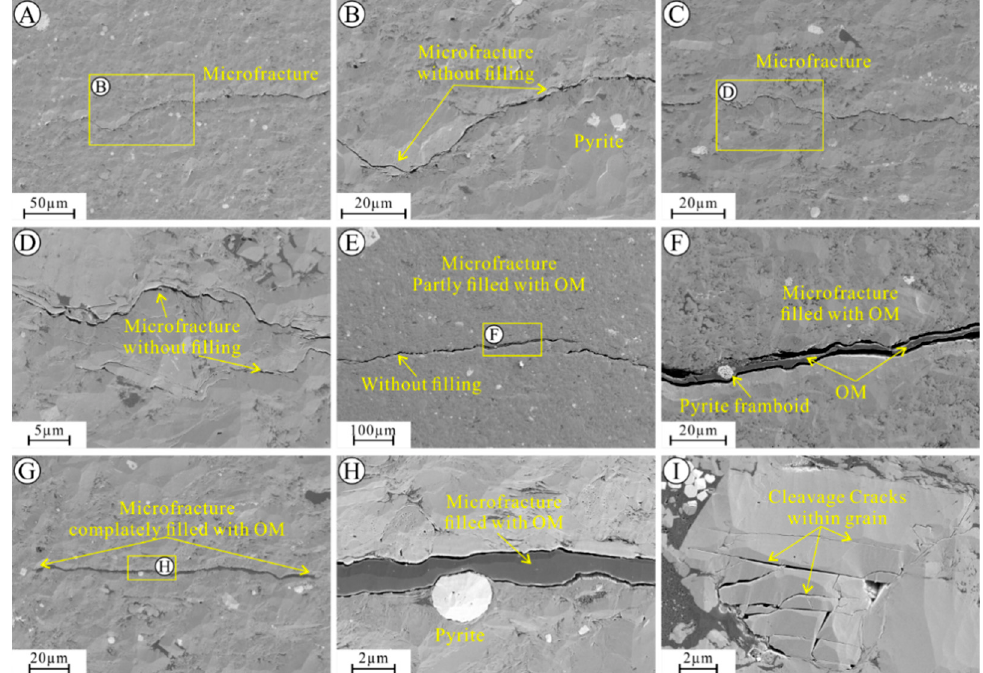
Figure 4. FE-SEM images of microfracture in Longmaxi shale samples. ( A , B ) Microfracture without filling, Sample W205-3; ( C , D ) Microfracture without filling, Sample W205-3; ( E ) Microfracture partly filled with organic matter, Sample N213-13; ( F ) Microfracture filled with organic matter, Sample N213-13; ( G , H ) Microfracture filled with organic matter, Sample W205-3; ( I ) Cleavage cracks within grain, Sample